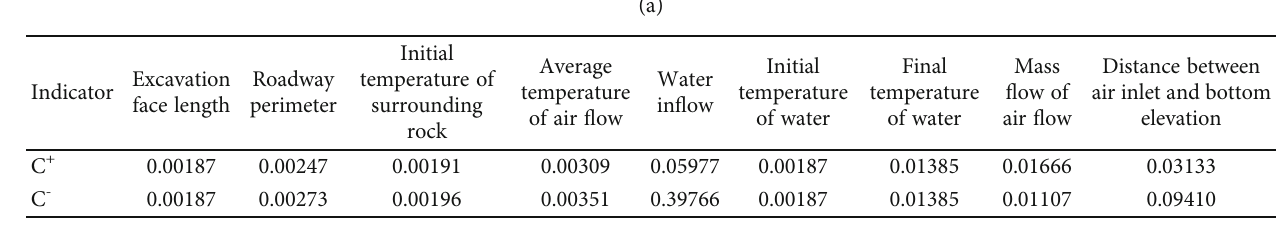
Table 9: Positive and negative ideal solutions of each indicator. (a)